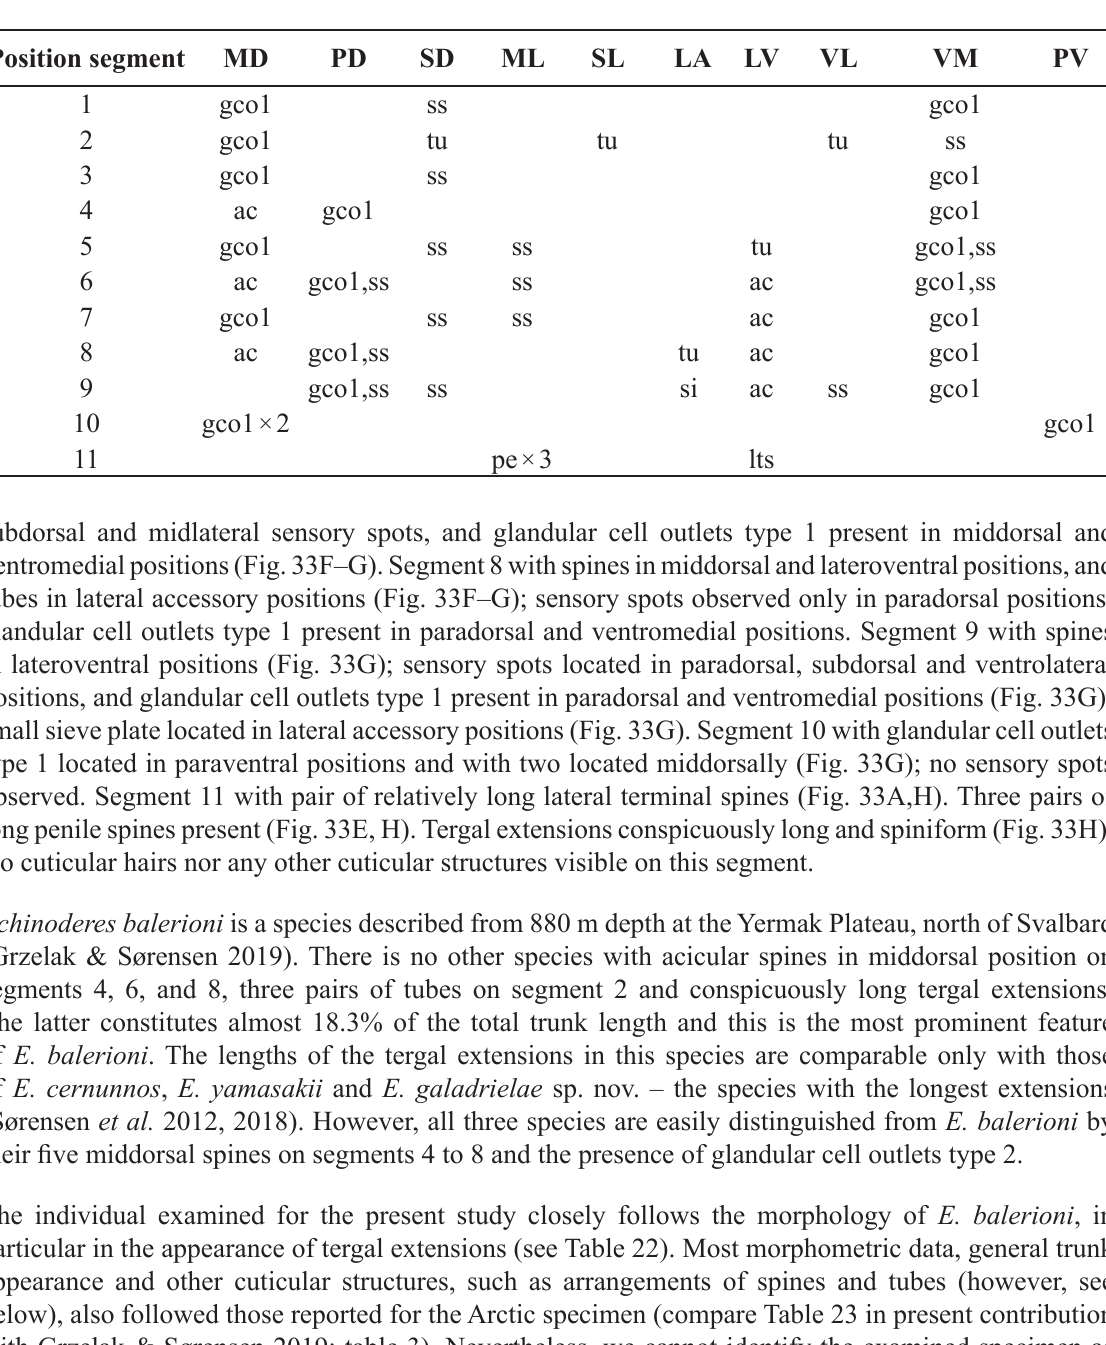
Table 23. Summary of nature and location of sensory spots, glandular cell outlets, tubes and spines arranged by series in Echinoderes sp. aff. E. balerioni